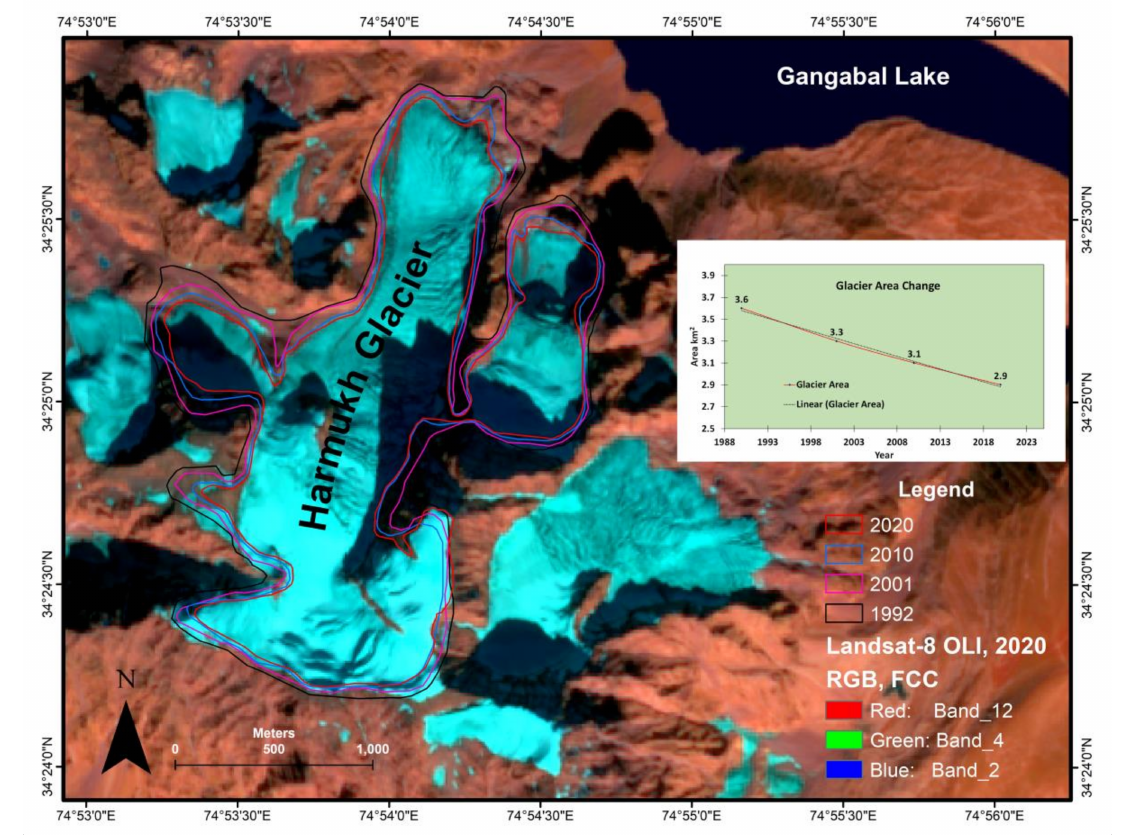
Figure 8. Glacier area changes from 1990 to